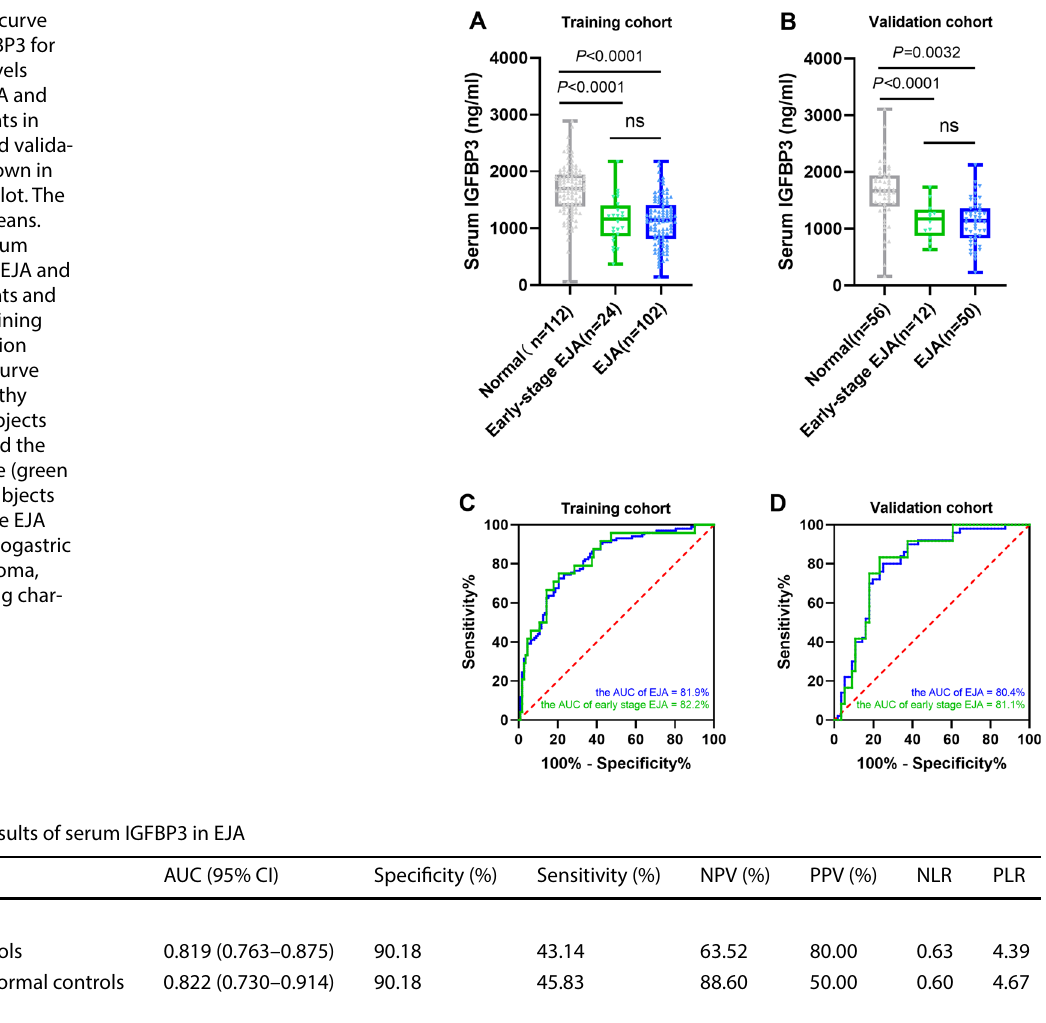
EJA esophagogastric junction adenocarcinoma, AUC area under the curve, 95% CI 95% confidence interval, NPV negative predictive value, PPV positive predictive value, NLR negative likelihood ratio, PLR positive